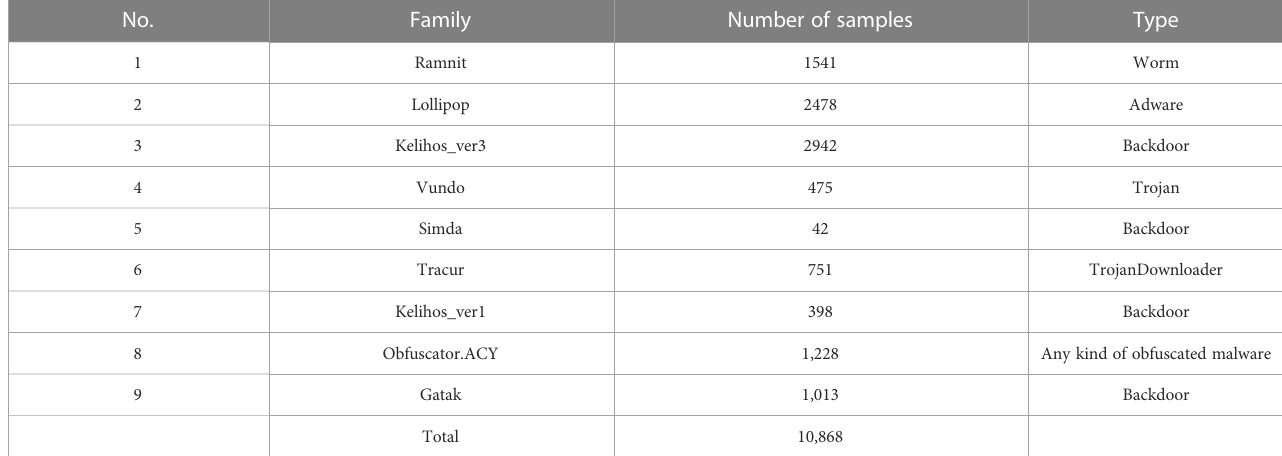
TABLE 1 Malware families in the training